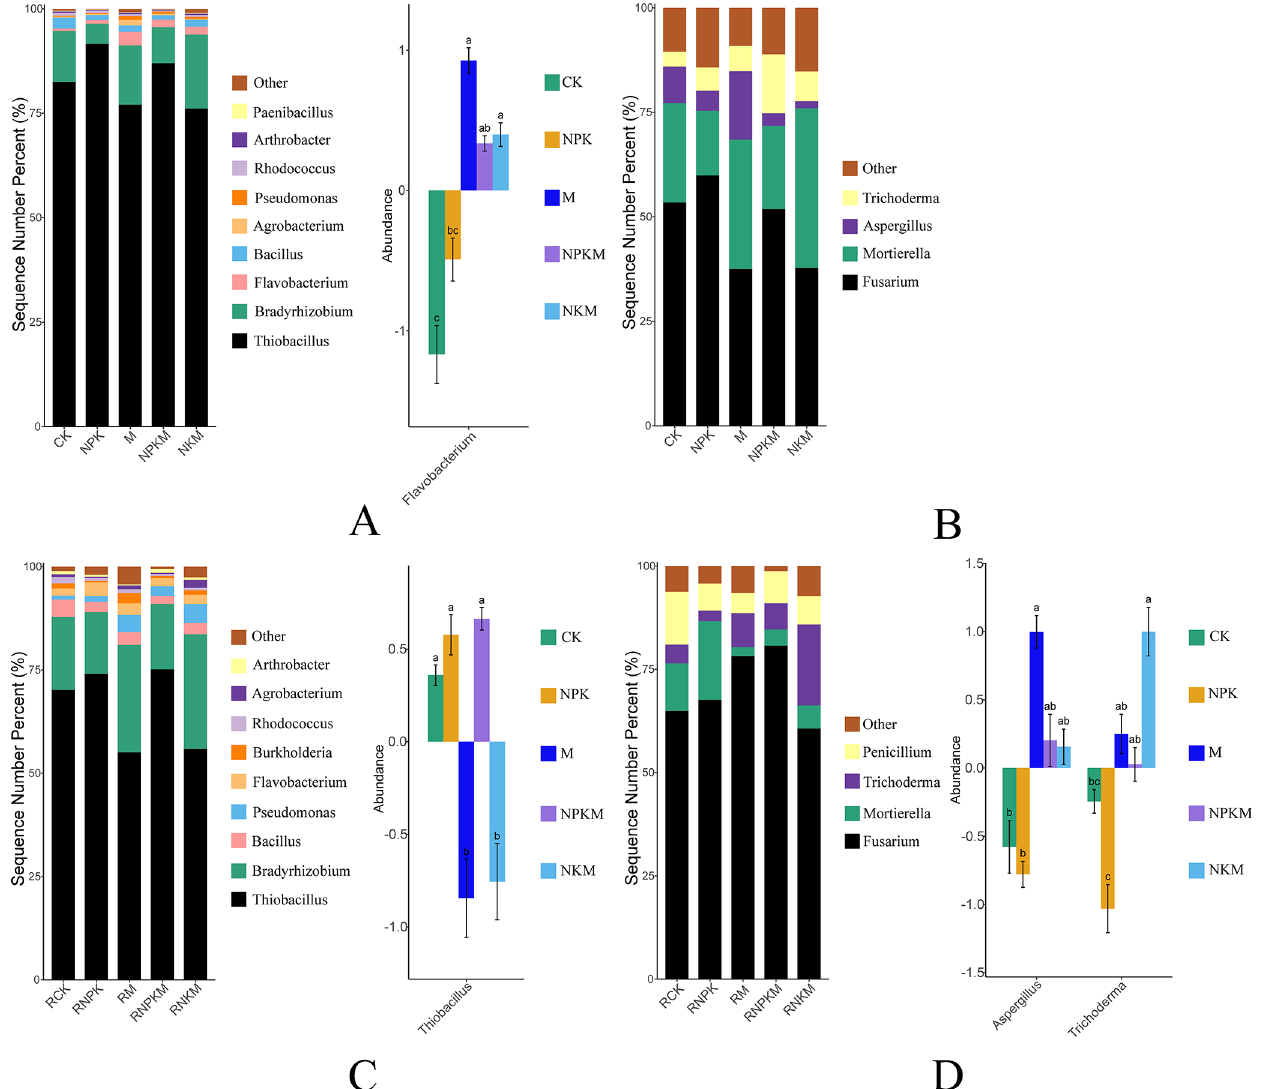
Figure 3. The relative abundance of phosphate-solubilizing microorganisms (left) and features with significant differences (Anova + Duncan; p < 0 . 05; n = 6) between groups (right) at the genus level in five treatments (CK, NPK, M, NPKM, and NKM). Capital letters mean different classification ( A – bacteria in bulk soil; B – fungi in bulk soil; C – bacteria in rhizosphere soil; D – fungi in rhizosphere